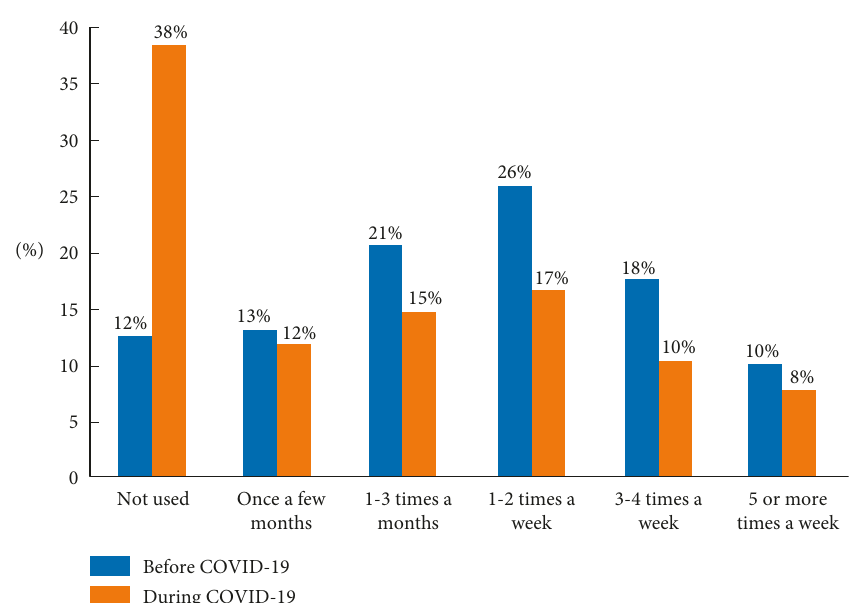
Figure 2: Frequency of using shared mobility before and during COVID-19 (abbreviated as “shared_frequency”).